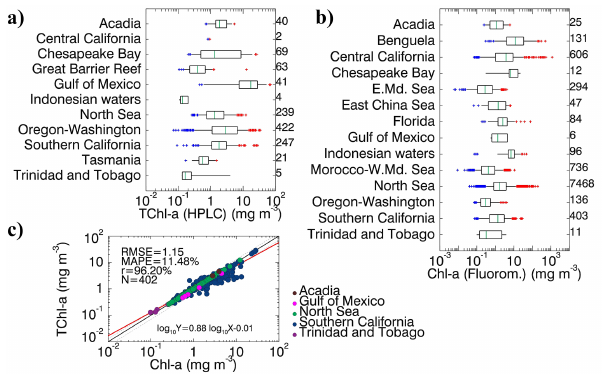
Figure 7. The distribution of (a) TChl a and (b) Chl a concentra- tions (in mgm − 3 ) as given in the in situ data set at all measure- ment depths, and (c) Chl a vs. TChl a . The number of measure- ments taken at each test site is reported on the right axis of the graph. The graphical convention in panels (a) and (b) is identical to Fig. 6. In panel (c) the solid line represents the 1:1 ratio, the dashed lines ± 30%, and the red line the linear regression fitting the log-transformed TChl a and Chl a